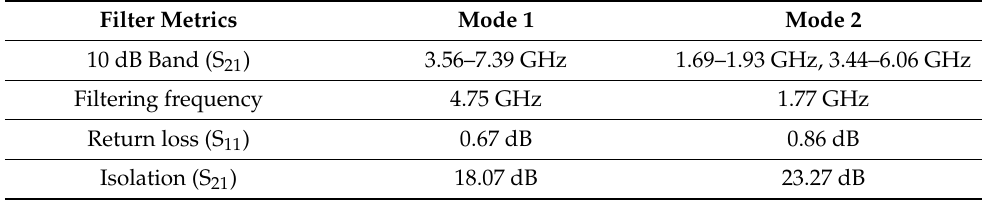
Figure 8. Characteristics of the bandstop filter in ( a ) mode 1 and ( b ) mode 2. Table 1. Simulated results of filter performance.